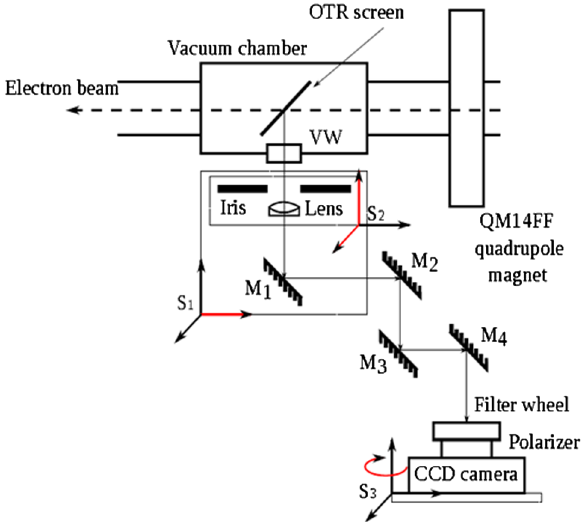
FIG. 10. Typical beam image (a) and corresponding horizontal (b) and vertical (c)